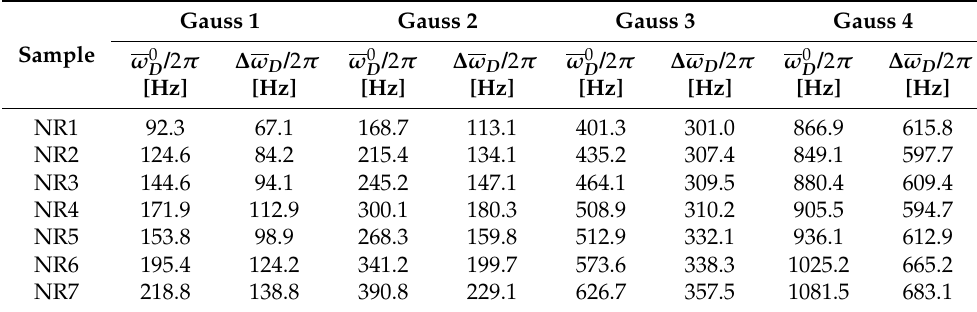
Table 3. The centers ω 0 /2 π and widths (cid:104) ω D /2 π (cid:105) of the Gaussian distributions obtained from D